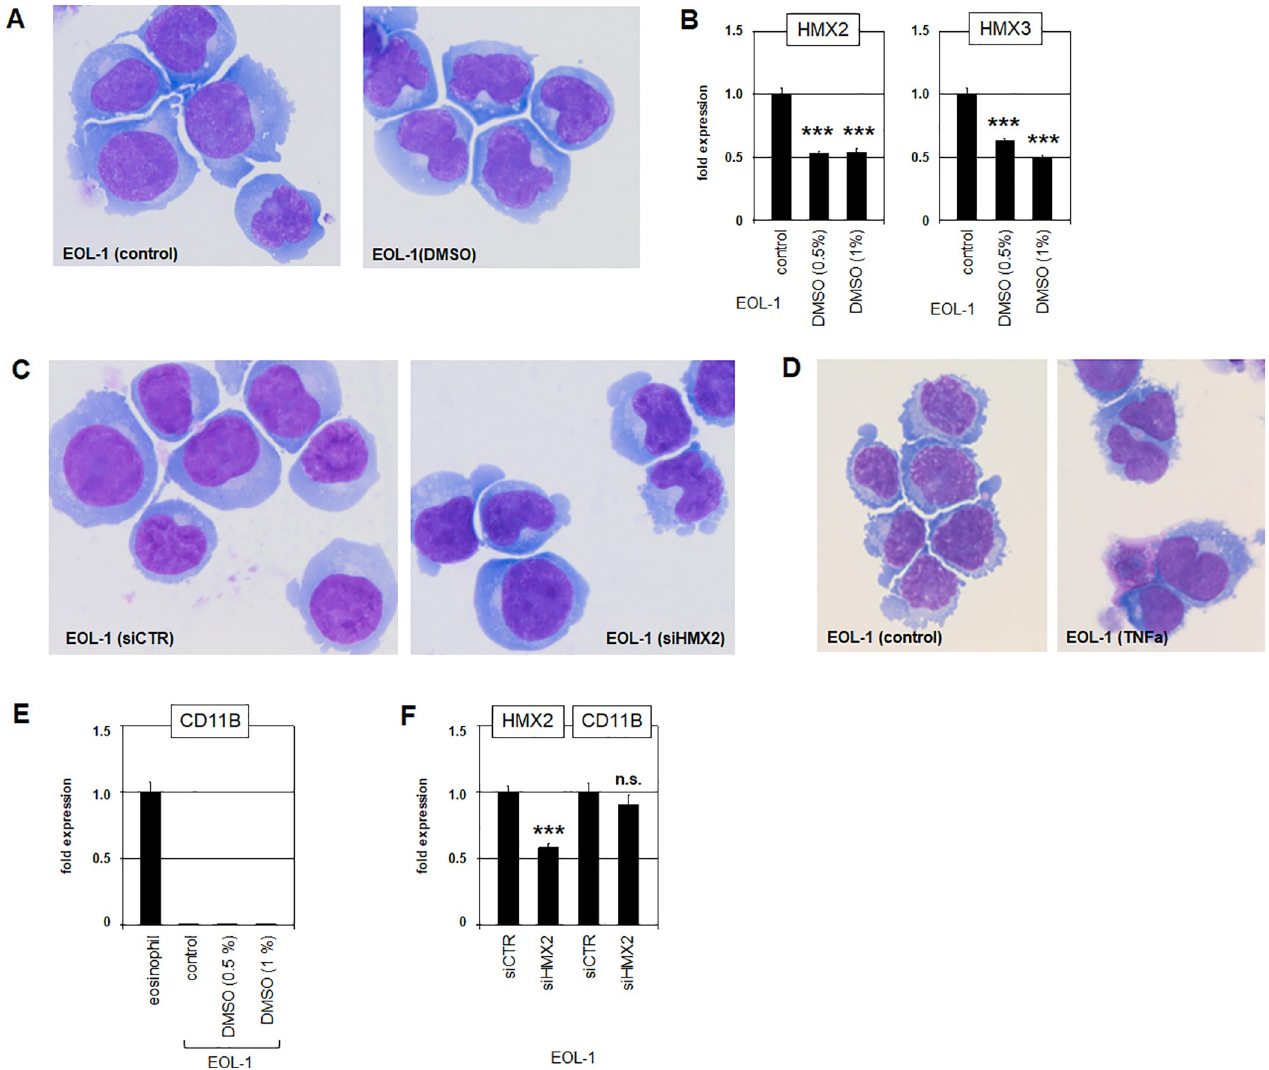
Fig 5. Differentiation of EOL-1. (A) Treatment of EOL-1 cells with DMSO for three days induced morphological alterations as shown by Giemsa-May- Gru¨nwald staining. The nuclei became typically indented like kidney beans which can be interpreted as eosinophilic differentiation. (B) The same treatment resulted in decreased expression of HMX2 (left) and HMX3 (right) as analyzed by RQ-PCR. SiRNA-mediated knockdown of HMX2 (C) or treatment with TNFa (D) generated the same nuclear indentation as visible after DMSO-treatment, indicating that HMX2/3 inhibited eosinophilic differentiation. (E) Marker expression. (F) Marker expression. Asterisks indicate calculated p-values obtained by t-Test analysis of controls (siCTR) and siRNA-targeted